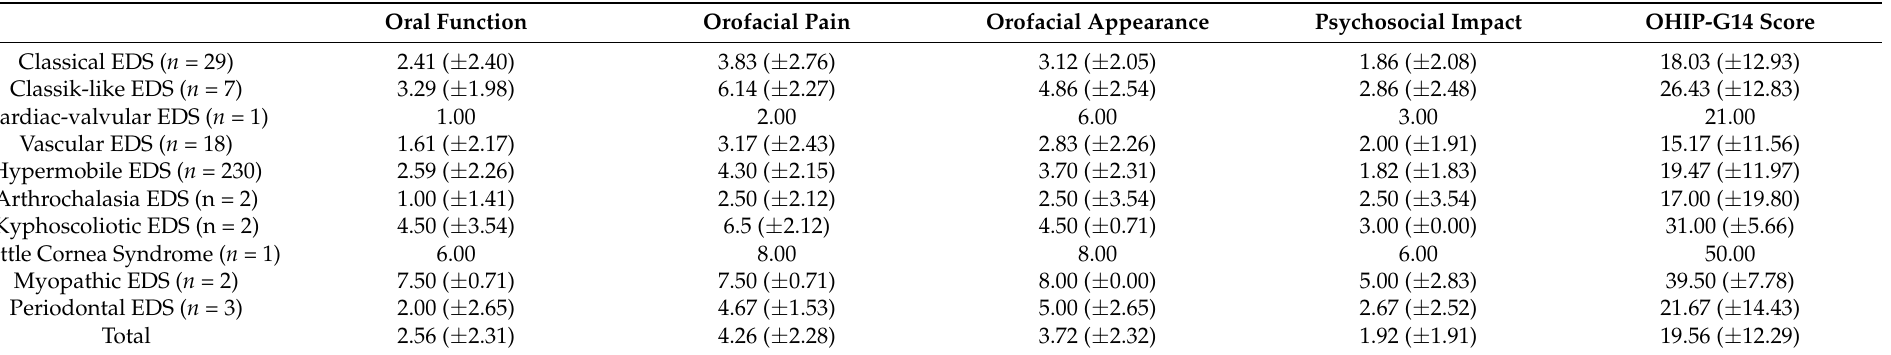
Table 2. Calculated scores for the four dimensions of Oral Health-Related Quality of Life (OHRQoL) and Oral Health Impact Profile (OHIP-G14) summary score; each score is given for the individual subtype and as a total across all subtypes; standard deviation not given for cardiac-vascular EDS (cvEDS) and Brittle Cornea Syndrome (BCS), only one participant,